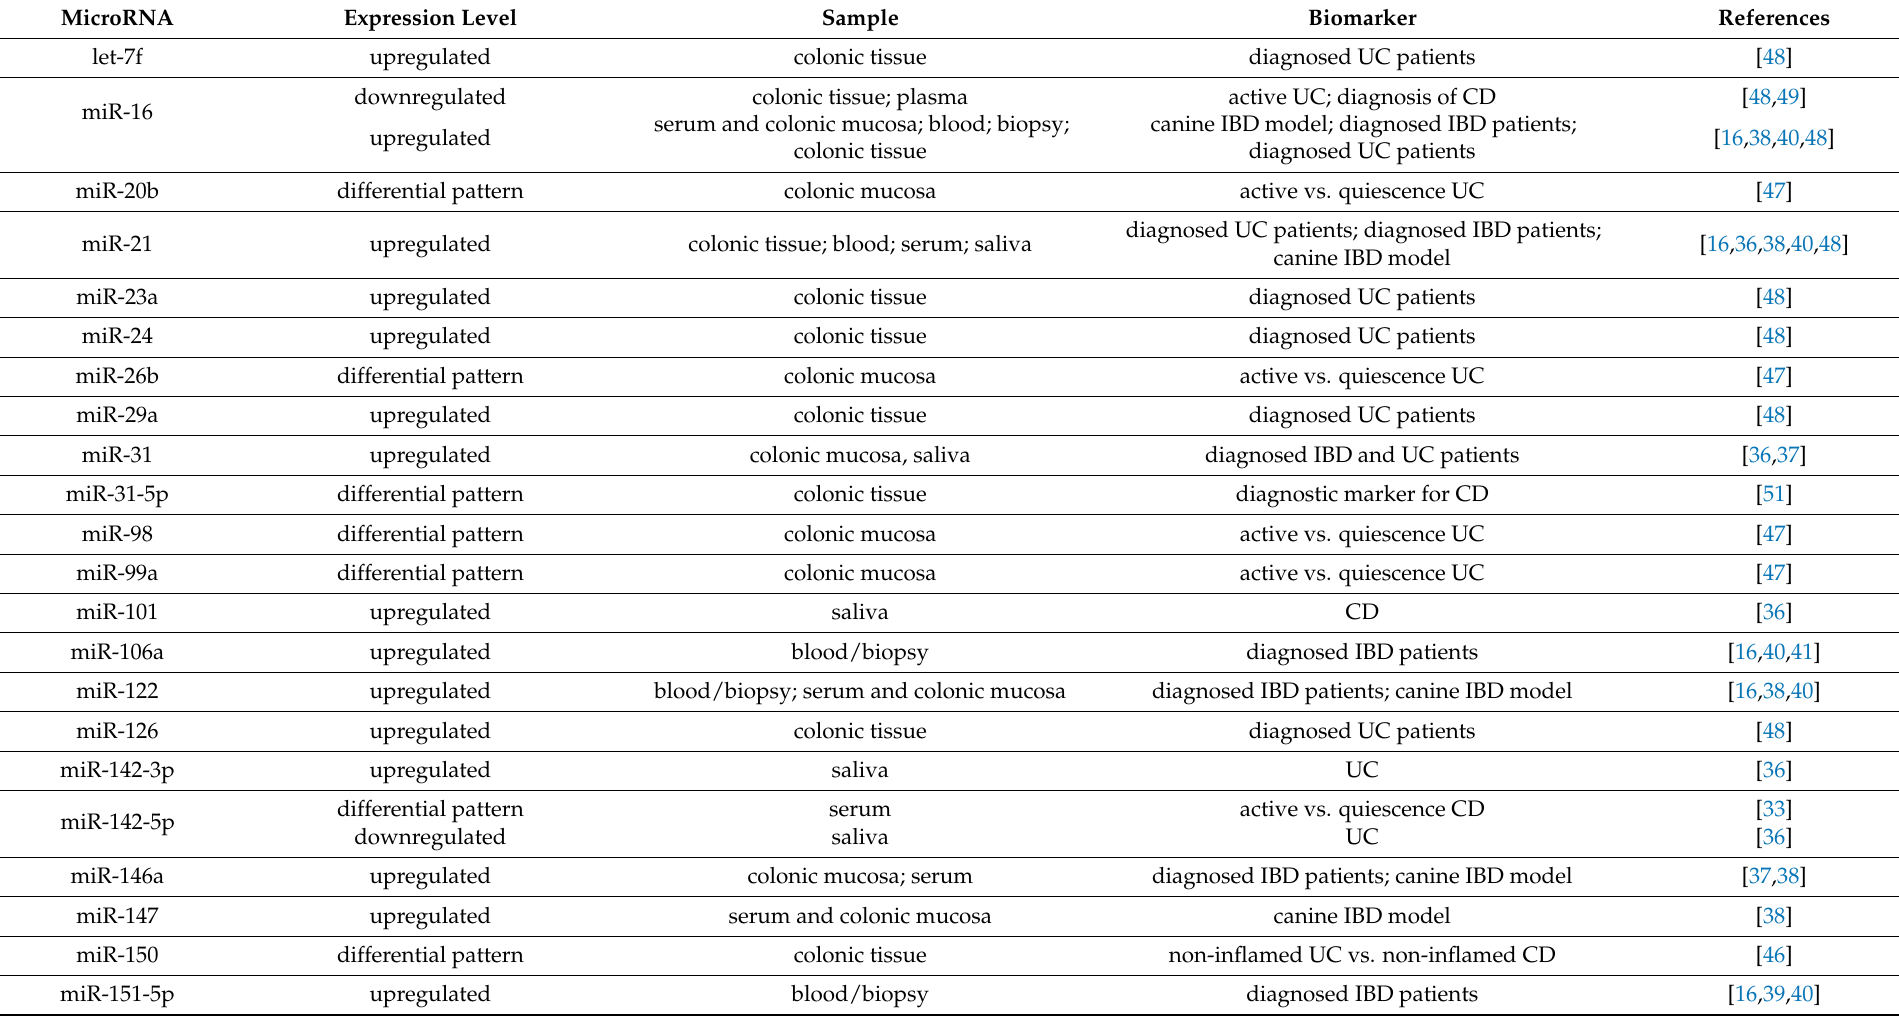
Table 1. Summary of altered microRNA expression patterns in